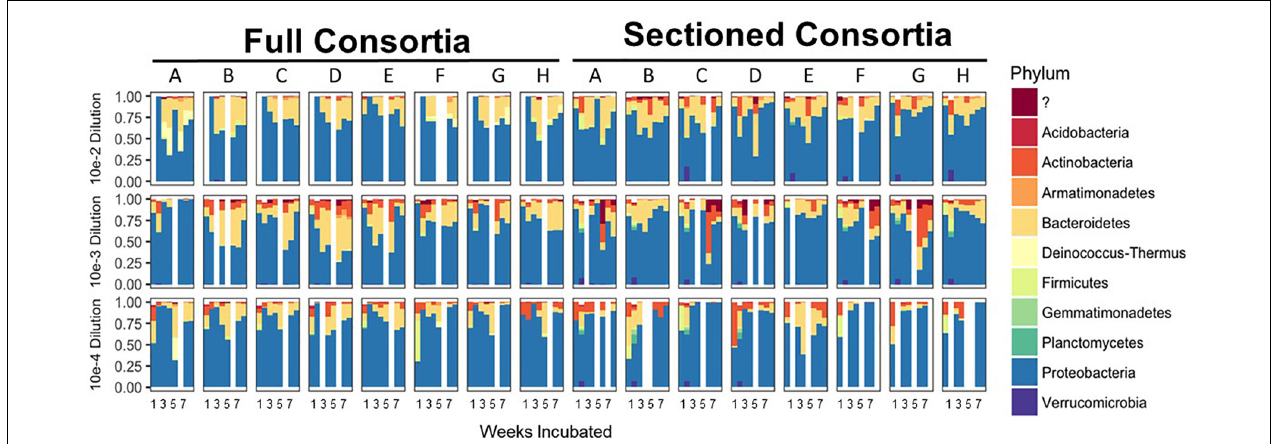
FIGURE 2 | Enrichment of reduced complexity communities on chitin/soil extract agar medium. Relative abundances for each microbial community at the phylum level are shown on the x-axes with communities from the 10 − 2 dilution on the top, 10 − 3 dilution in the middle, and 10 − 4 dilution on the bottom. Full and Sectioned communities from the agar medium are, respectively, labeled and the weeks of incubation are shown on the y-axes.